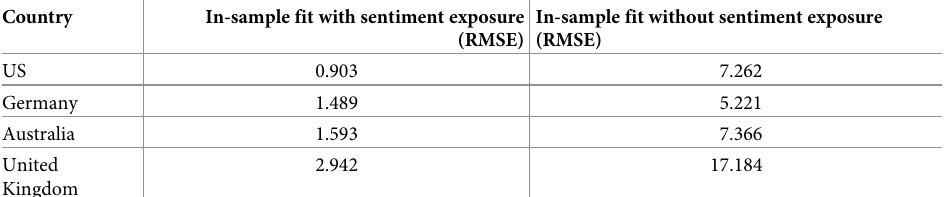
Table 9. Root mean squared error (RMSE) for the in-sample fits for model M2 at the beginning of the pandemic, with and without the sentiment exposure adjustment.